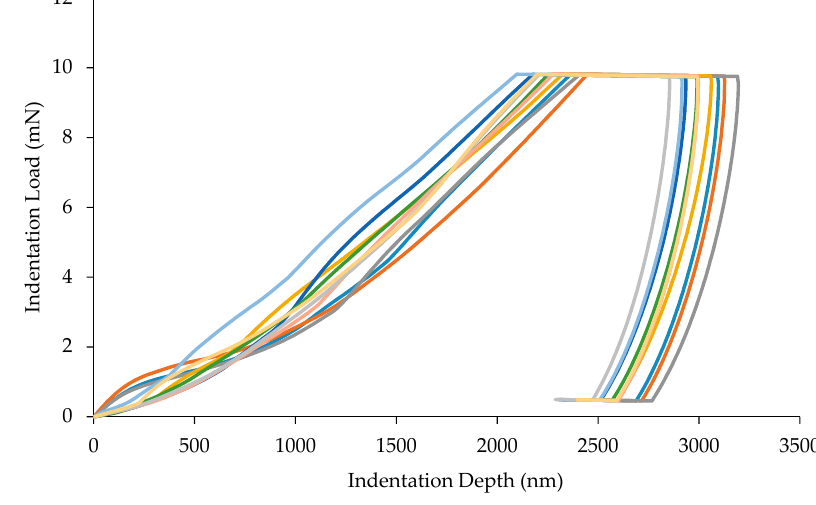
Figure 4. Load-displacement curve for 10 indents on mastic phase.